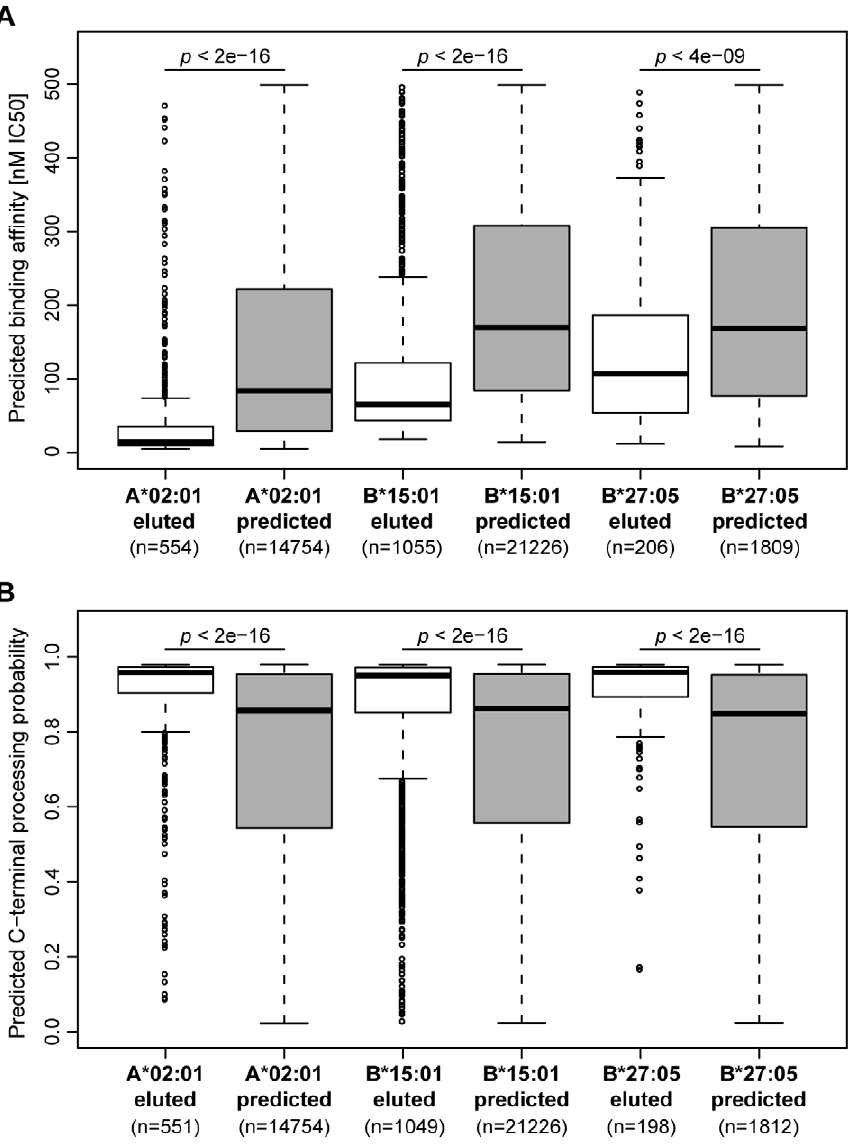
Figure 2. Eluted peptides show higher binding affinity to HLA and more efficient C-terminal processing. The boxplots compare eluted 9mer peptides and predicted binders from the same set of source proteins in terms of ( A ) predicted binding affinity to A*02:01, B*15:01, and B*27:05, respectively, and ( B ) predicted C-terminal processing probability. For the matter of correctness, we removed eluted peptides from the data set that had also been part of the NetChop training set ( n